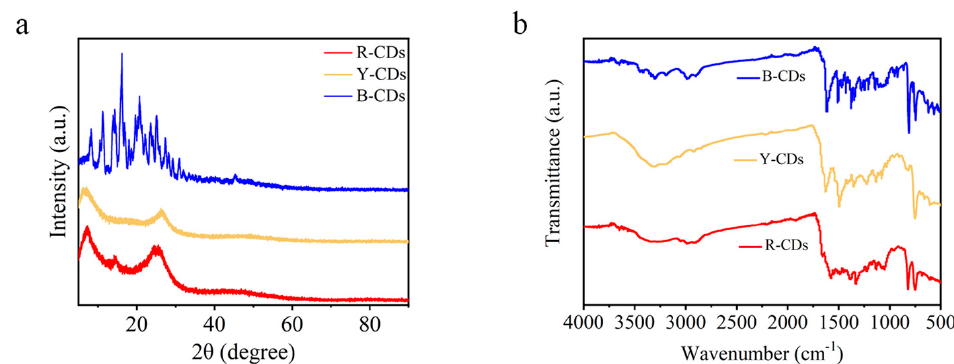
Figure 2. ( a ) XRD and ( b ) FTIR spectra of MCDs.